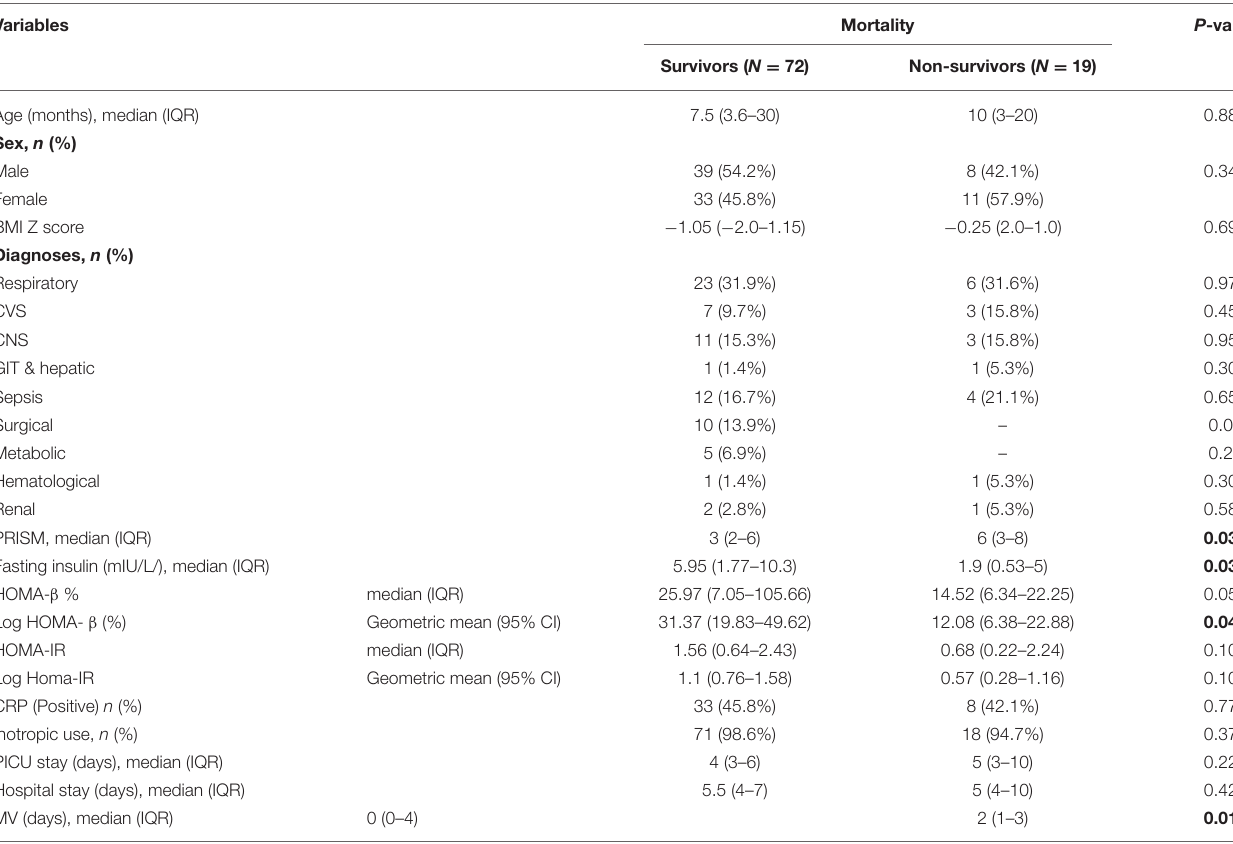
TABLE 2 | Comparison between survivors and non-survivors with regard to clinical data and outcome parameters ( N = 91).